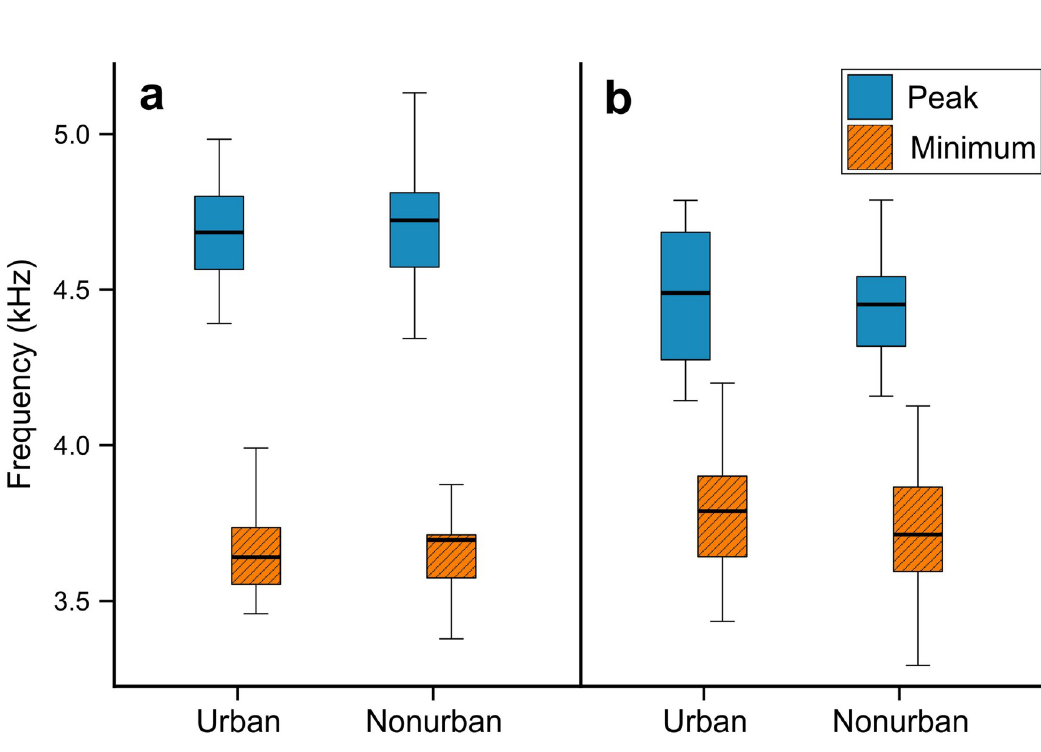
Fig 4. Box-and-whisker plots describing variation in Common Chiffchaffs (a) and Willow Warblers (b) syllable minimum and peak frequency in relation to sampling site. Boxes indicate median and first and third quartiles. Whiskers represent the minimal and maximal values within 1.5 times the interquartile